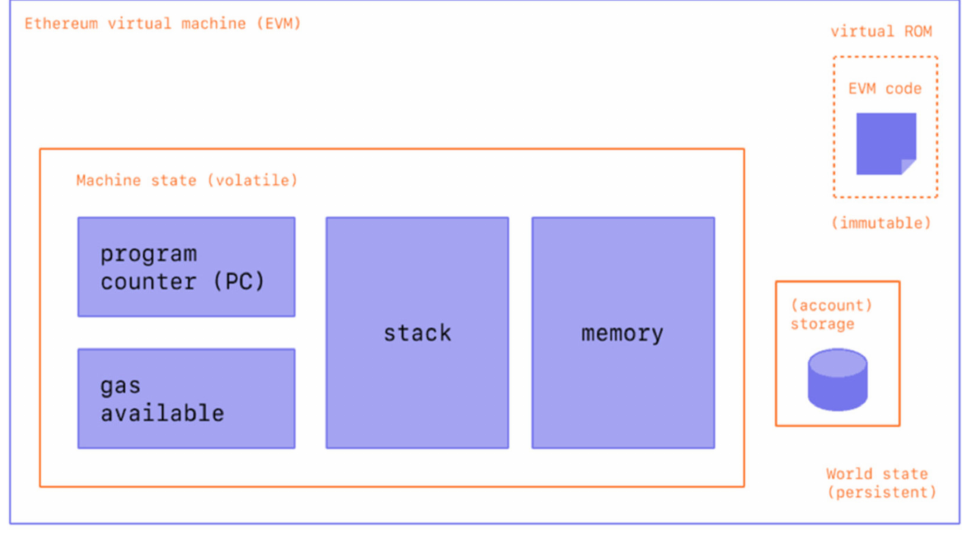
Figure 1. EVM architecture